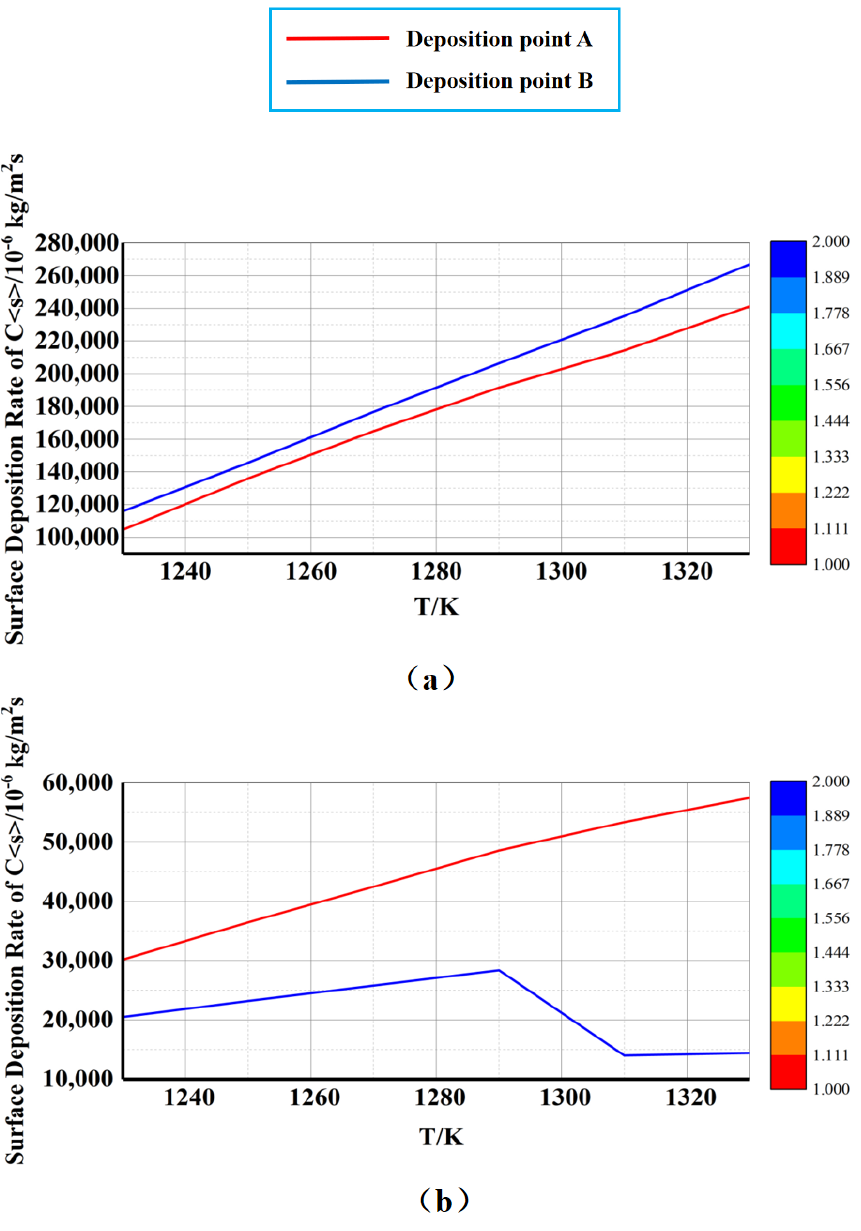
Figure 10. Atmospheric and low pressure surface deposition rate of c
with different temperatures in forward and reverse flow: ( a ) AP (101,325 Pa); ( b ) LP (660 Pa).